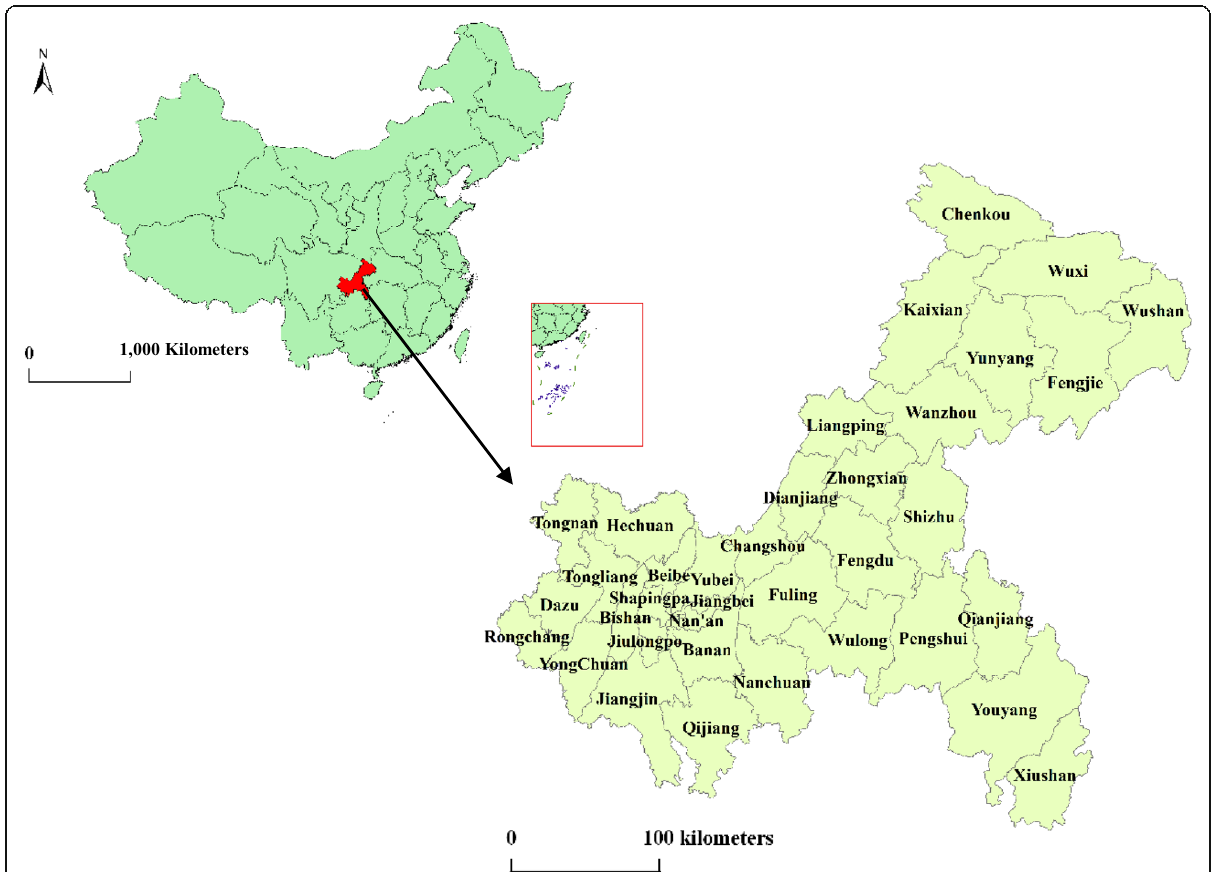
Fig. 1 Administrative division map in Chongqing at the county